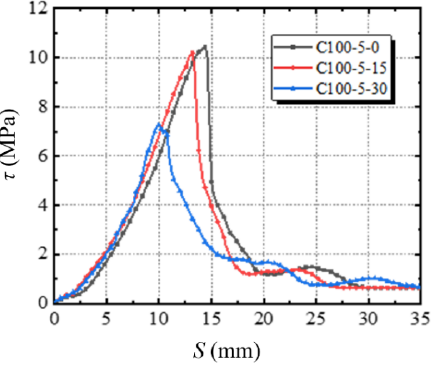
Figure 11. Bond stress–slip curves of reinforcing bars for 0, 15 and 30 freeze–thaw cycles.